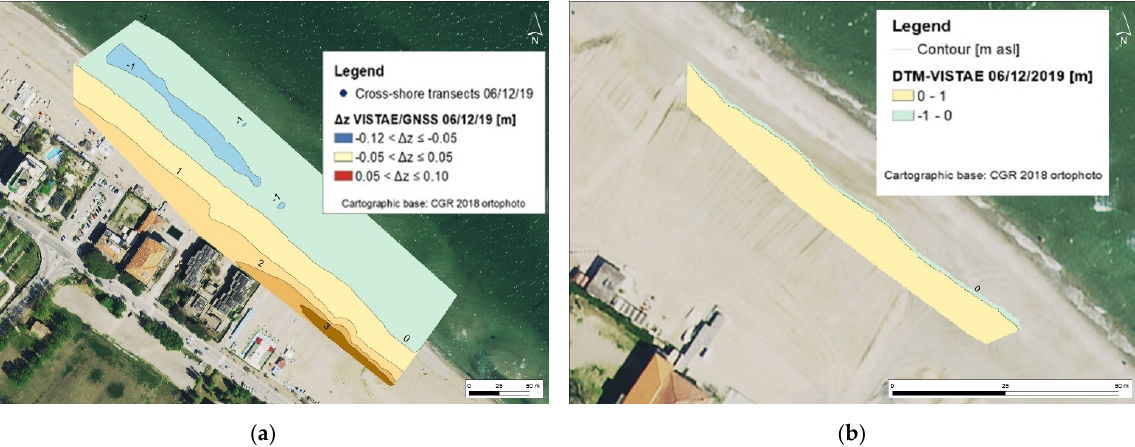
Figure 5. 3D elevation model of the intertidal bathymetry obtained at the time of survey 2 (6 December 2019): ( a ) from field survey (GNSS); ( b ) from remote observations by VISTAE camera. The background photo is an orthorectified image taken from Regional Service Portal (http://geo.regione.emilia-romagna.it/cartografia_sgss/user/viewer.jsp, accessed on 12 January 2022). Water 2022 , 14 , x FOR PEER REVIEW 11 of 24 Figure 6a reports the elevation difference, Δ z , represented in three classes: negative differences are in blue, a central class with a range of ±0.05 m, which indicates no signifi- cant elevation difference (range of GNSS precision), are in light yellow and positive dif- ferences are in red. This comparison for survey 2 provided a strong correspondence be- tween the two models, with a mean value and standard deviation equal to ( − 0.02 ± 0.03) m and with 77% of data in the central class (see histograms in Figure 6c and Table 2).